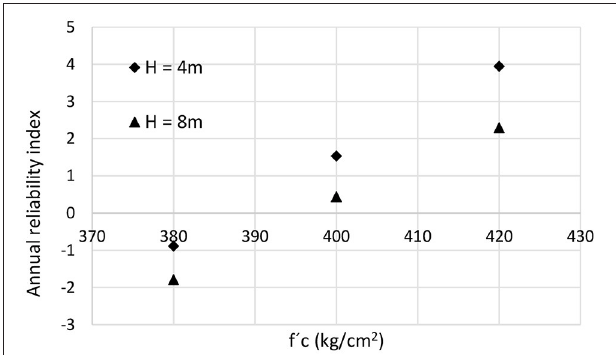
FIGURE 17 | Reliability index for several actual values of f ′ c, H = 4 and 8m,